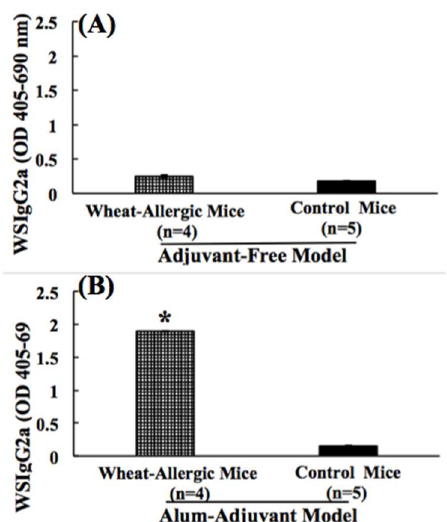
Figure 4. ( A , B ). Comparison of the wheat protein-specific IgG2a antibody responses in the adjuvant-free vs. the alum-adjuvant mouse models of wheat allergenicity. ( A ) In the AF model, Balb / c mice